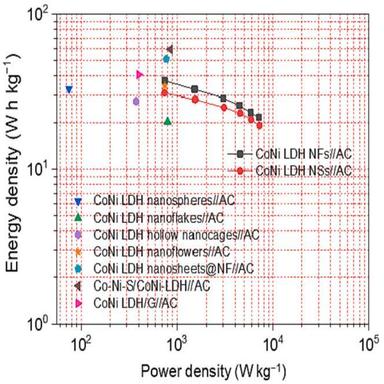
The Ragone plots of CoNi LDH NFs//AC HSC, CoNi LDH NSs//AC HSC, and some other CoNi LDH-based HSCs reported previously.